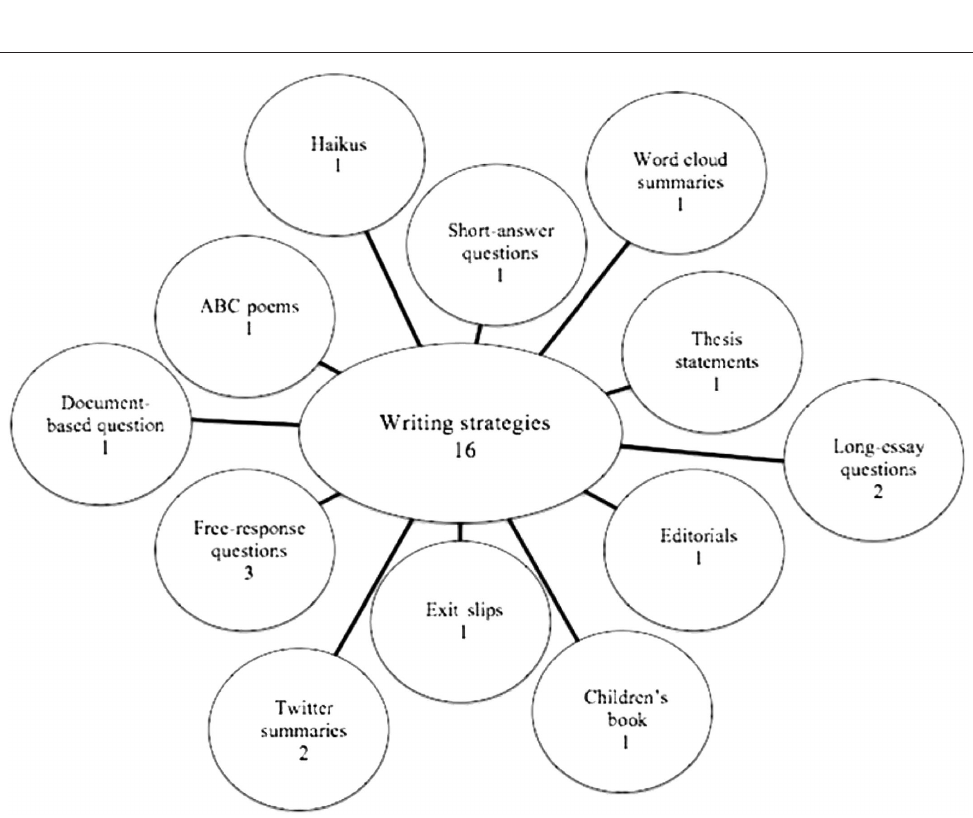
Figure 3: Writing strategies that teachers identified